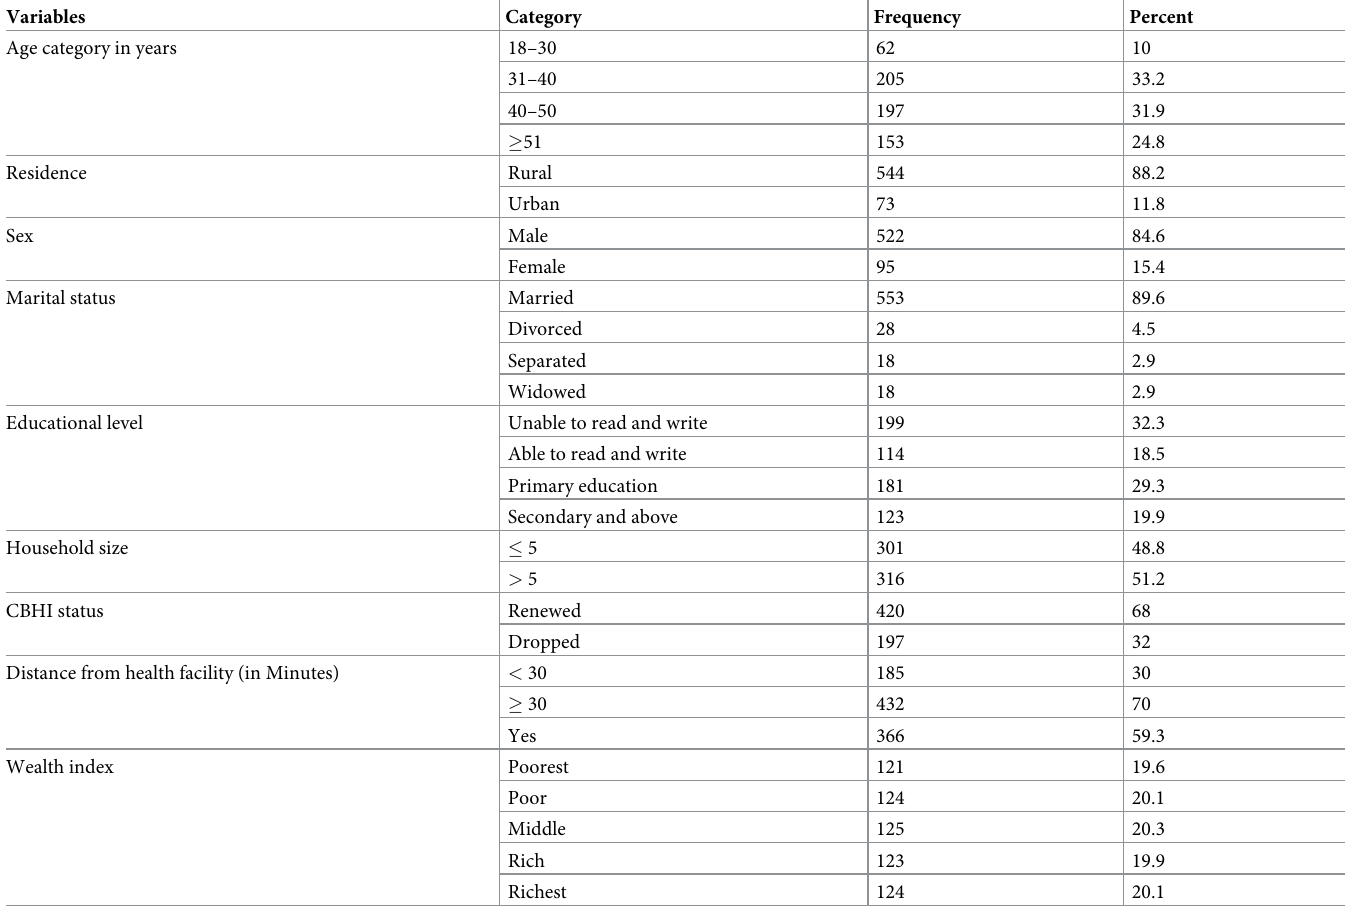
Table 1. Socio-economic and demographic characteristics of study participants among households in Manna district, Jimma zone, southwest, Ethiopia, 2020.